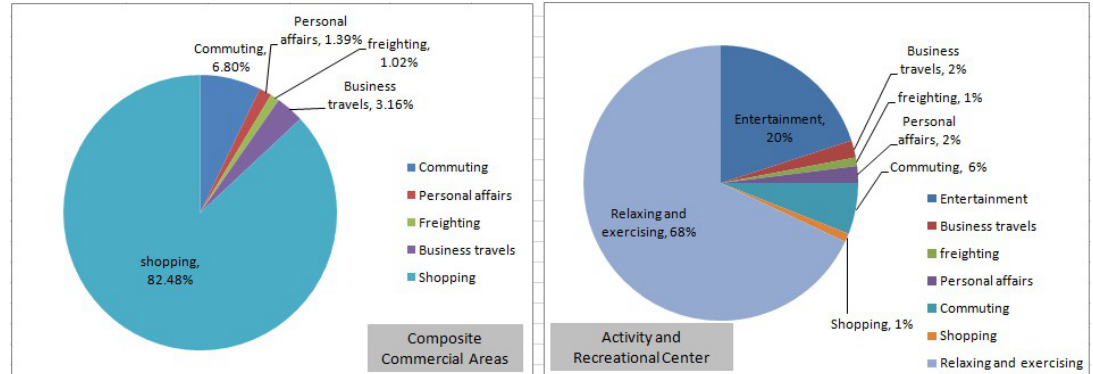
Fig. 5. Trip purpose distribution for people arriving at commercial and recreational areas in Beijing (2007) Source: Report on traveler-inviting sites of the third integrating investigation in Beijing transportation